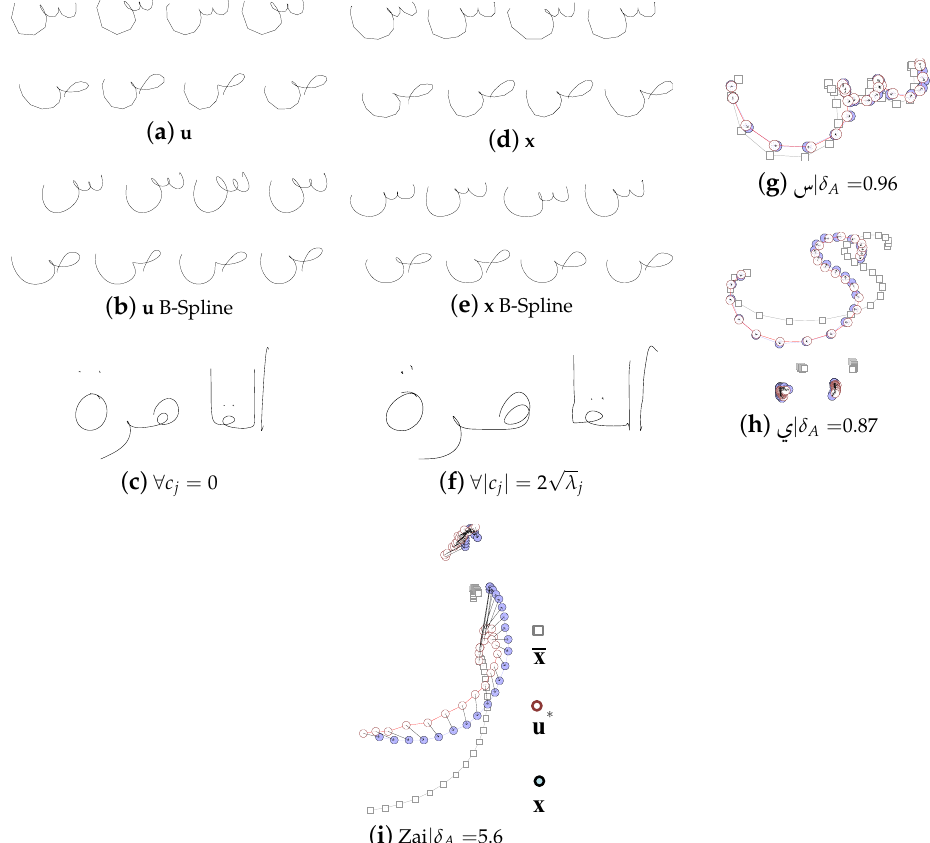
Figure 3. Building ASMs. ( a,b,d,e ) Examples for ASM representations u (where ∑ see Equation (2) ) and original letter samples x . B-Spline interpolation with 5 steps has been applied on ( b ) and ( e ). ( c ) and ( f ) show examples of u that are composed to words. Examples of ASM representations u ∗ that fit to samples x with the deviation δ A are shown in ( g – i